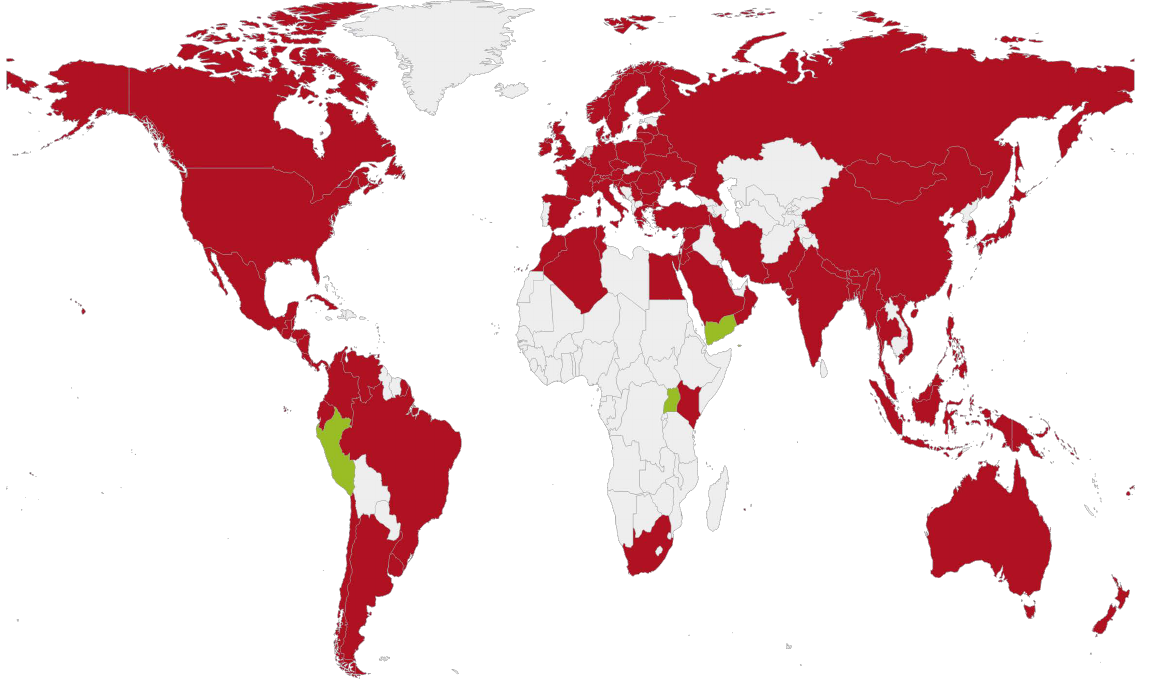
Figure 2. Worldwide distribution of sacbrood virus (SBV). The red color indicates the presence of SBV in the respective regions. The green color indicates regions where previous studies have not reported SBV infection. The gray color indicates that data are not available in these